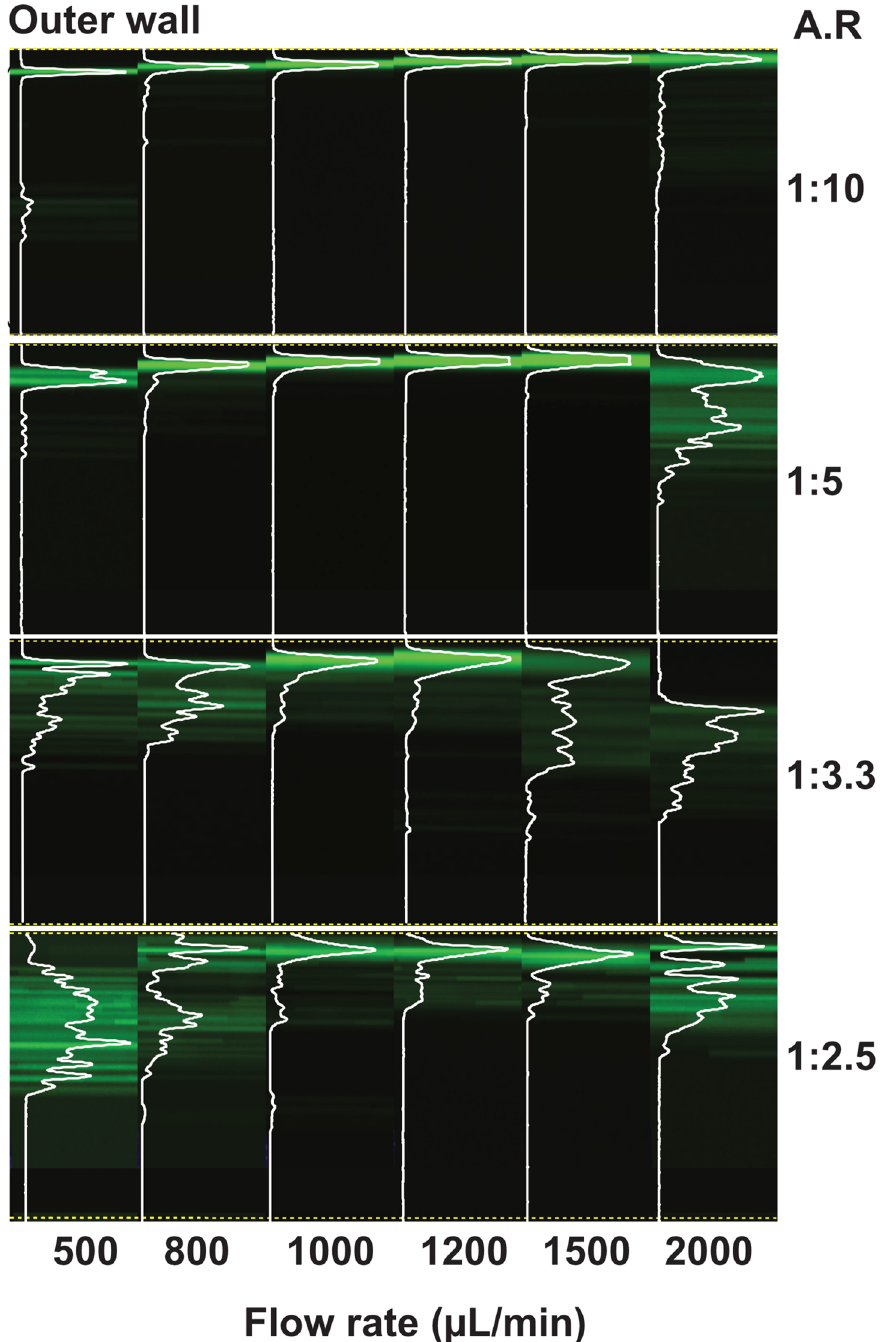
Figure 5. Particle focusing as a function of channel aspect ratio. Fluorescence images of 10 µm particles are overlapped with corresponding cross-section intensity to illustrate the focusing behavior at different flow rates. The lower the aspect ratio the better particle focusing is observed. Flow through low aspect ratio (AR: 1:10) result in stable 3D single stream focusing across the different flow rates tested. For the higher the aspect ratio (AR: 1:5–1:2.5), three regimes can be distinguished: at low flow rate, the particles are spread and at 1 ml/min particles are focused at the outer wall and further increase in flow rate results in defocusing of the